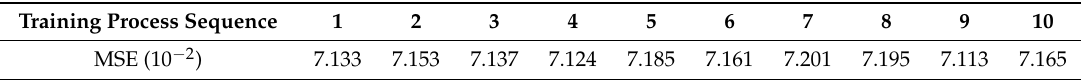
Table 1. Mean square errors (MSE) of the training results when number of hidden layer neurons N = 8. Training Process Sequence